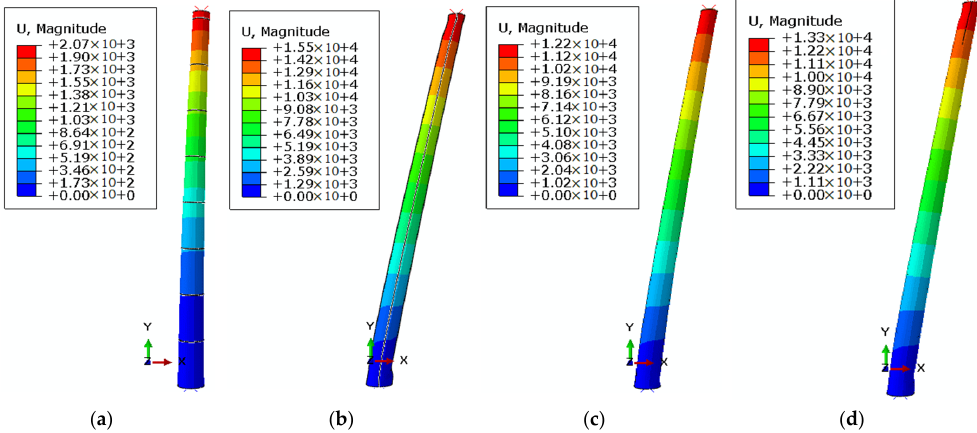
Figure 18. Post buckling behavior of towers I, II, III, IV under horizontal force. ( a ) Tower I, ( b ) Tower II, ( c ) Tower III, ( d ) Tower IV, (in mm).